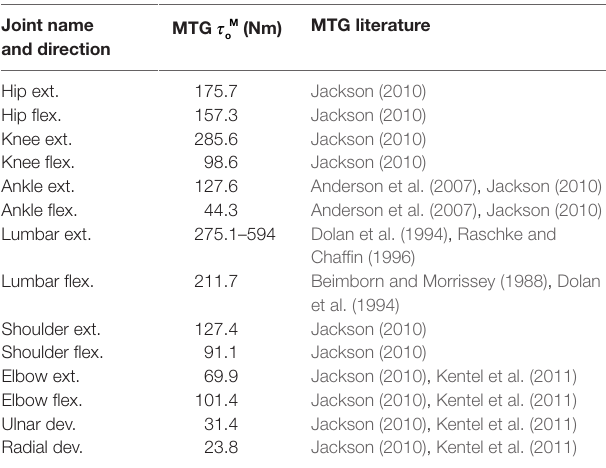
table 1 | Maximum isometric torque of the MTGs and the literature used to derive the characteristic curves for each of the MTGs.